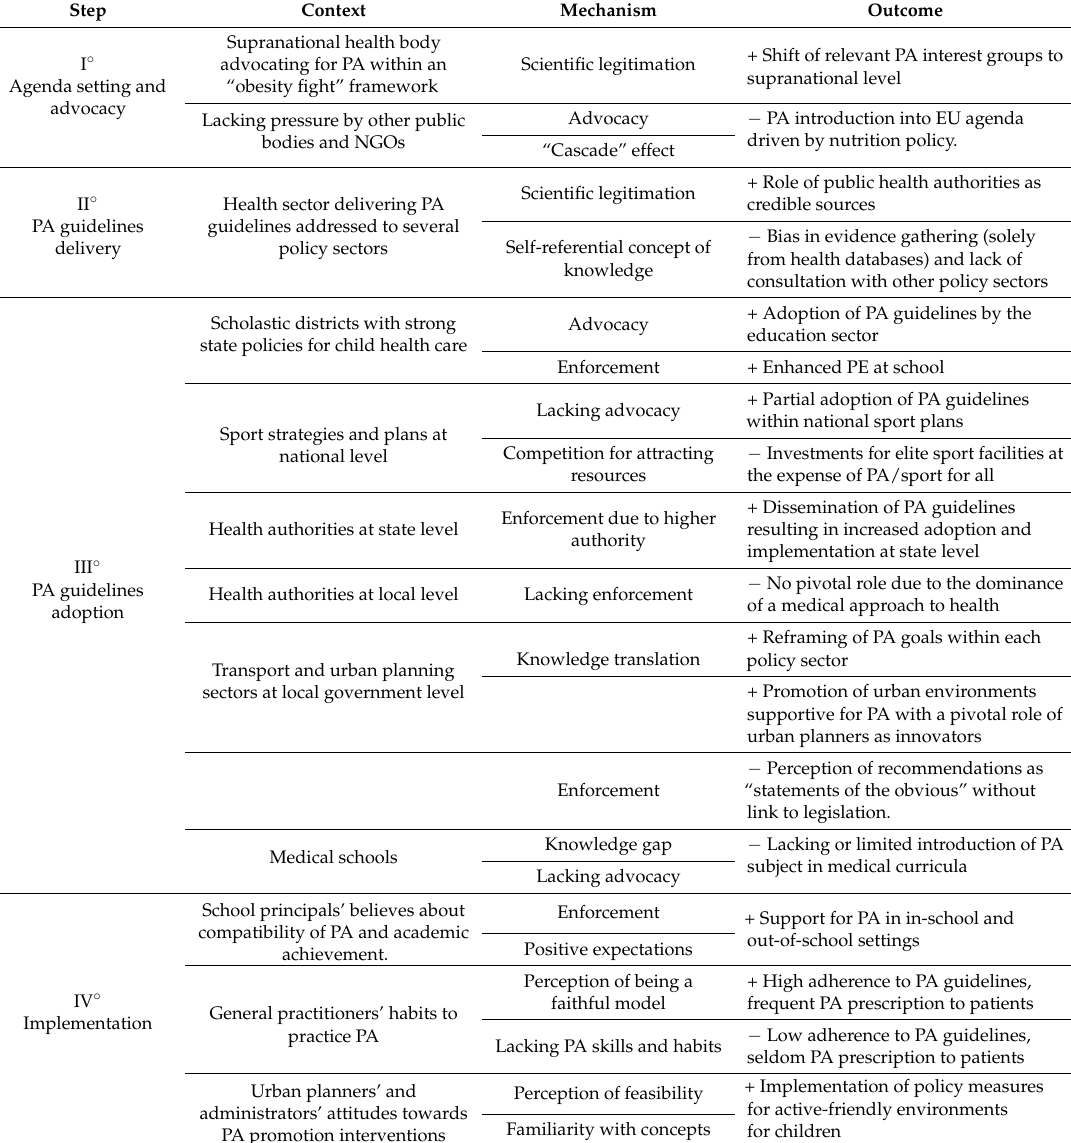
Table 1. Examples of context-mechanism-outcome